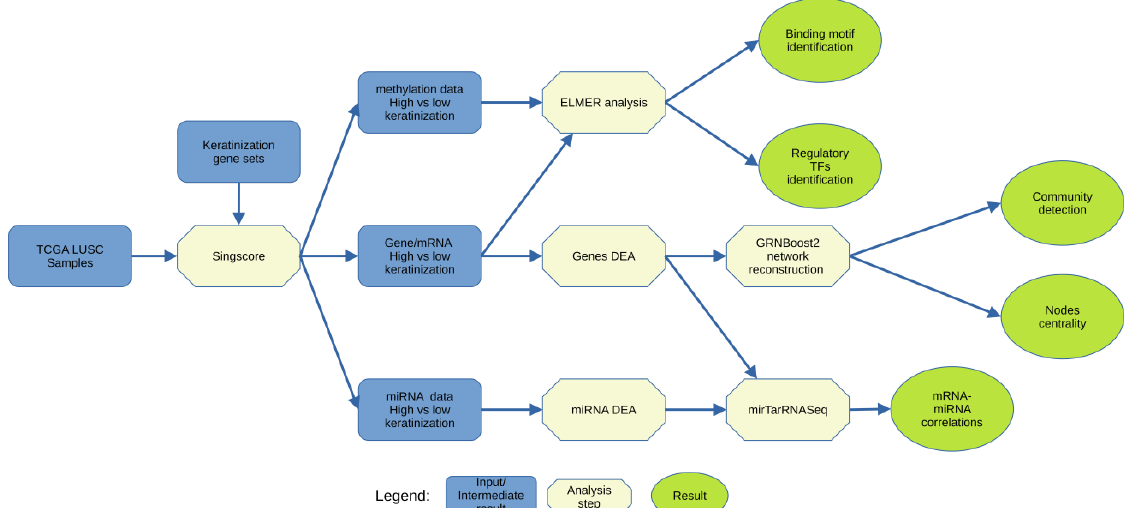
Figure 1. Overall pipeline of the analysis in our study. We divided the LUSC samples using single- sample gene set scoring, Singscore, with keratinization-related gene sets. Then, we performed differential expression analyses (DEA) of gene, methylation, and miRNA expression between high keratinization and low keratinization groups. Differentially expressed gene networks, ELMER, and mirTarRNASeq analysis were performed to identify key regulatory genes, transcription factors, and miRNA.